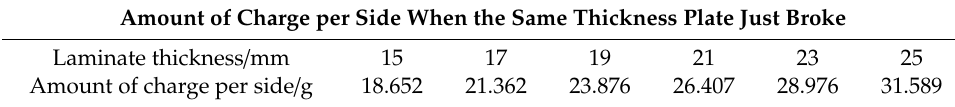
Table 5. Amount of charge per side when the same thickness plate just